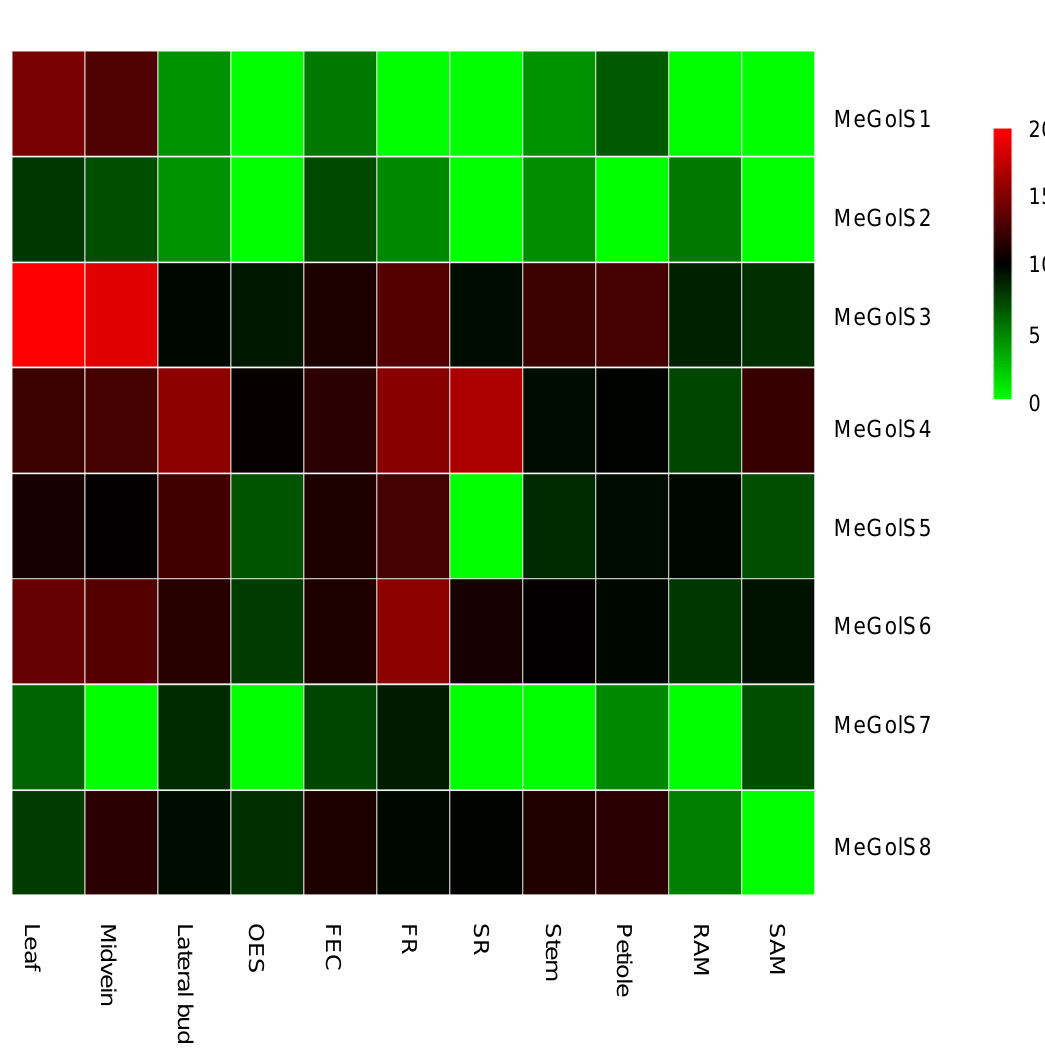
Figure 4. Expression abundance of MeGolSs in different tissues and organs of cassava. Leaf, leaf blade; midvein, leaf mid-vein; SAM, shoot apical meristem; SR, storage roots; FR, fibrous roots; RAM, root apical meristem; OES, somatic organized embryogenic structures; FEC, friable embryogenic callus. The bar on the upper right corner indicated the FPKM (fragments per kilobase of exon per million reads mapped) values that corrected by Log2, and different colors indicate different expression levels.